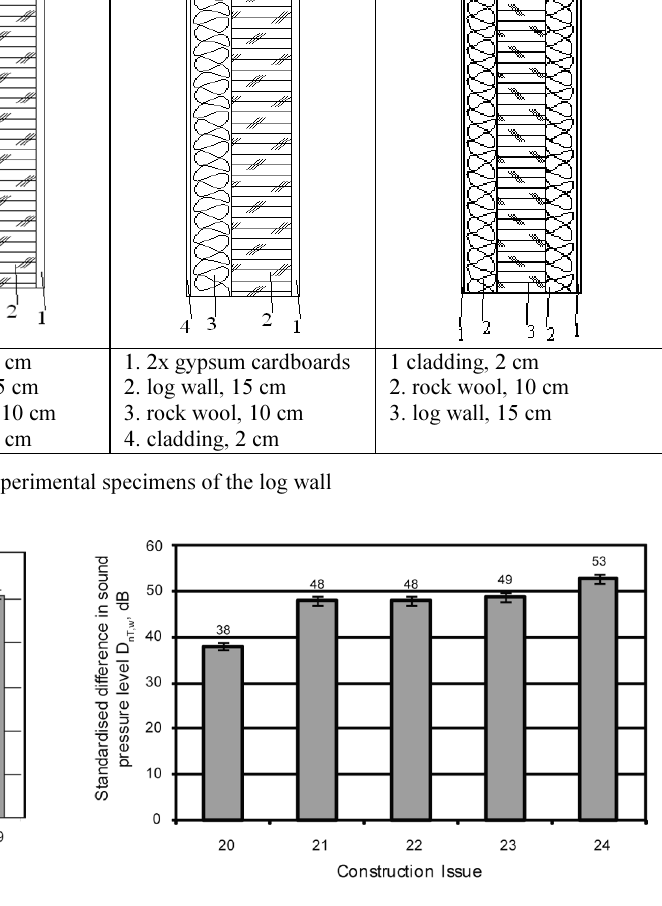
Fig. 13. Results of the standardised difference in sound pressure level D nTw of